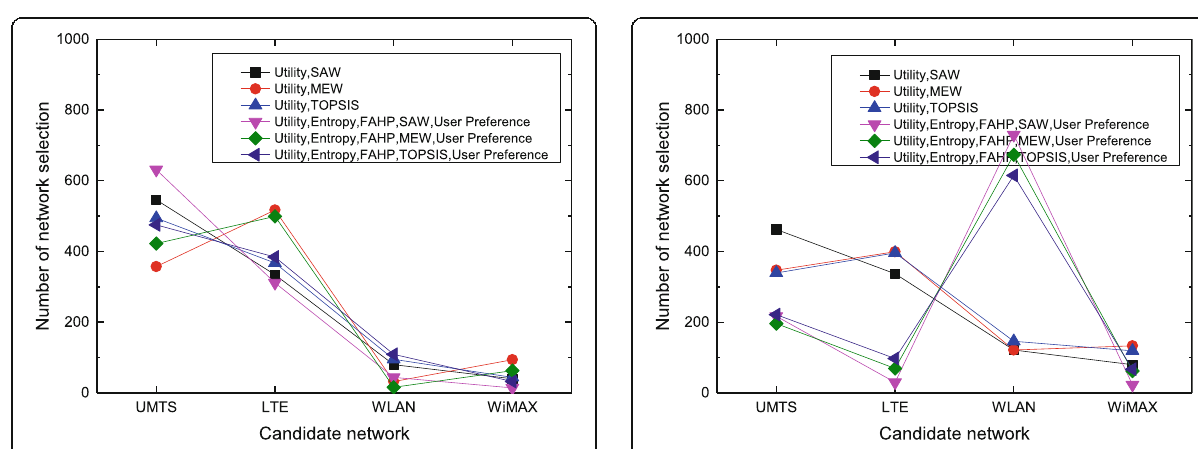
Fig. 15 Number of network selection of candidate networks for different algorithms for data